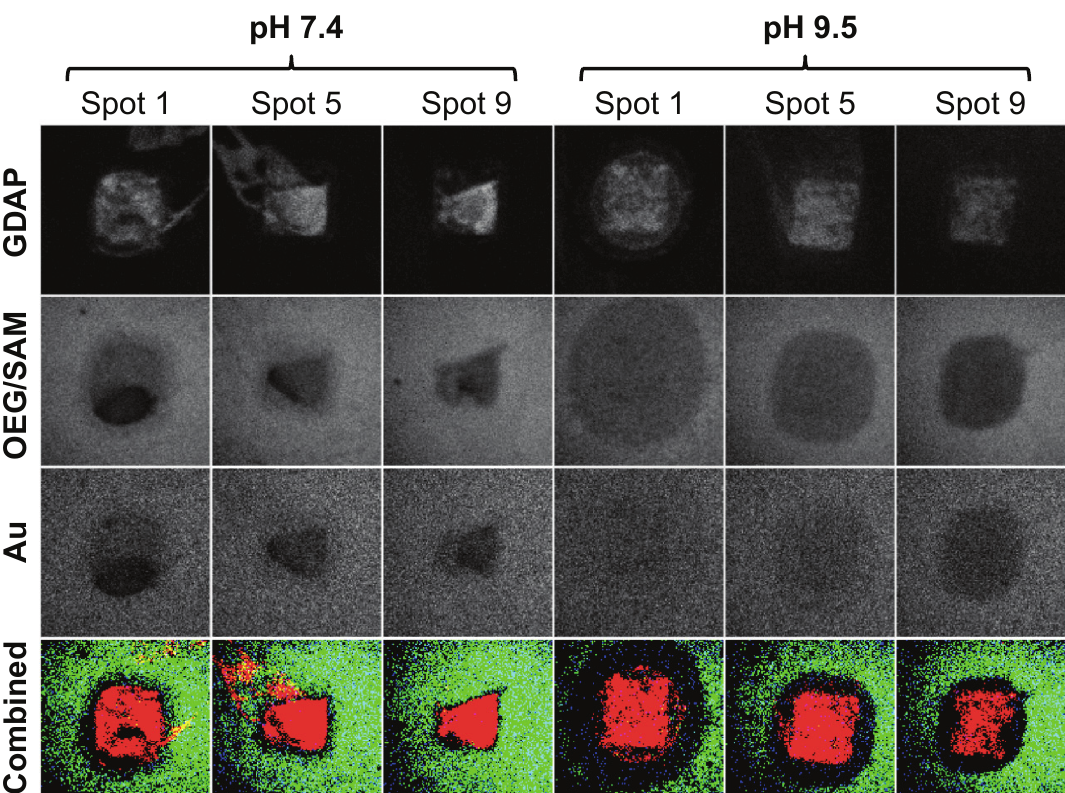
1, 5, and 9 were chosen for analysis because they represented the beginning, middle, and end of a sequence of microarray printing, respectively. Using the peaks identified by PCA